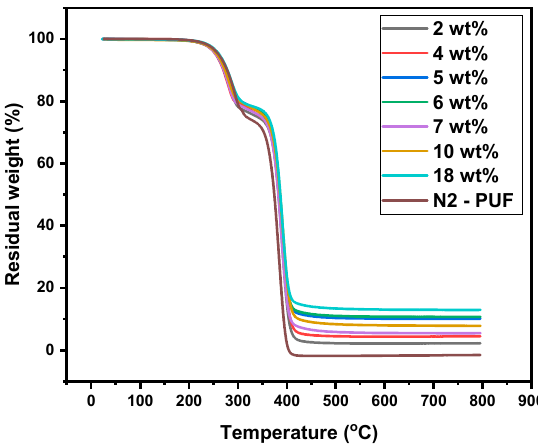
Figure 17. Laponite / CA-pdms-fu—90 / 10 wt% in di ff erent nanocomposite uptakes. Figure 17. Laponite/CA-pdms-fu—90/10 wt% in different nanocomposite uptakes.